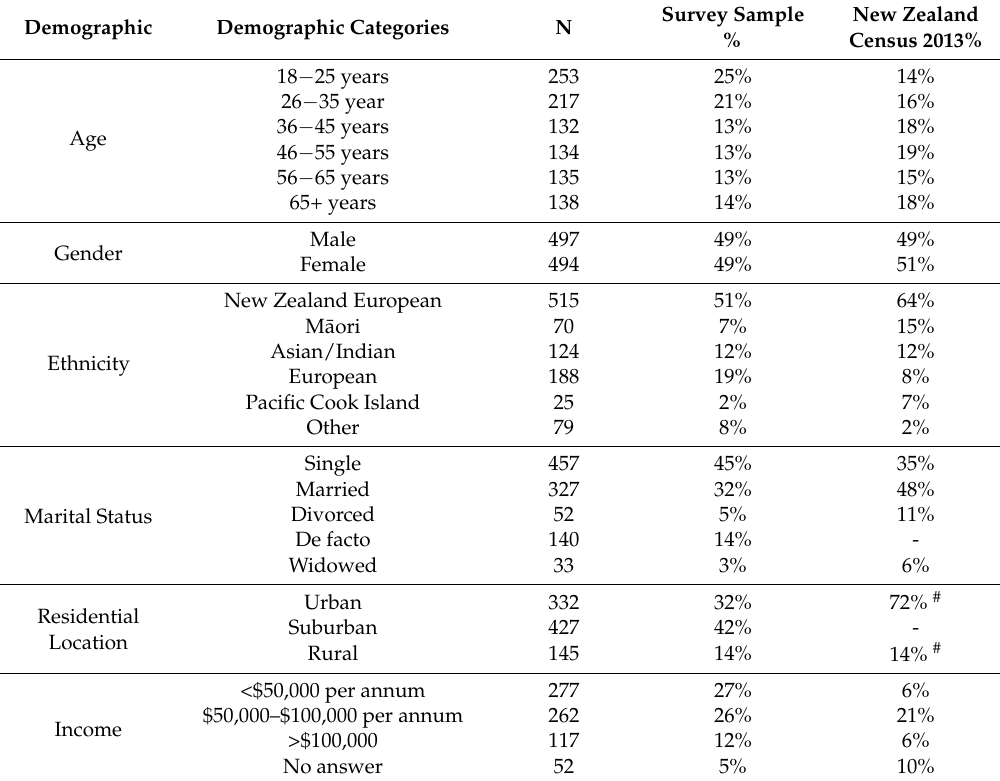
Table 1. Participant demographics ( n = 1011) showing a comparison of survey sample sizes with New Zealand national